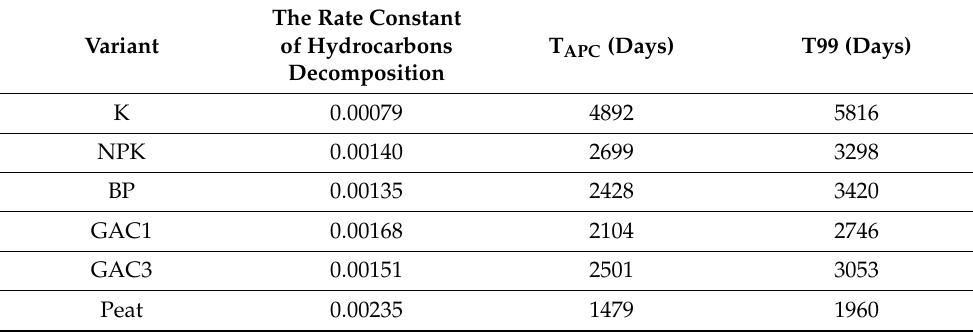
Table 4. Time of practically full degradation ( Т 99) and degradation to approximate permissible concentration ( Т APC , 700 mg/kg) of petroleum hydrocarbons in soil. concentration ( Т APC , 700 mg/kg) of petroleum hydrocarbons in soil.